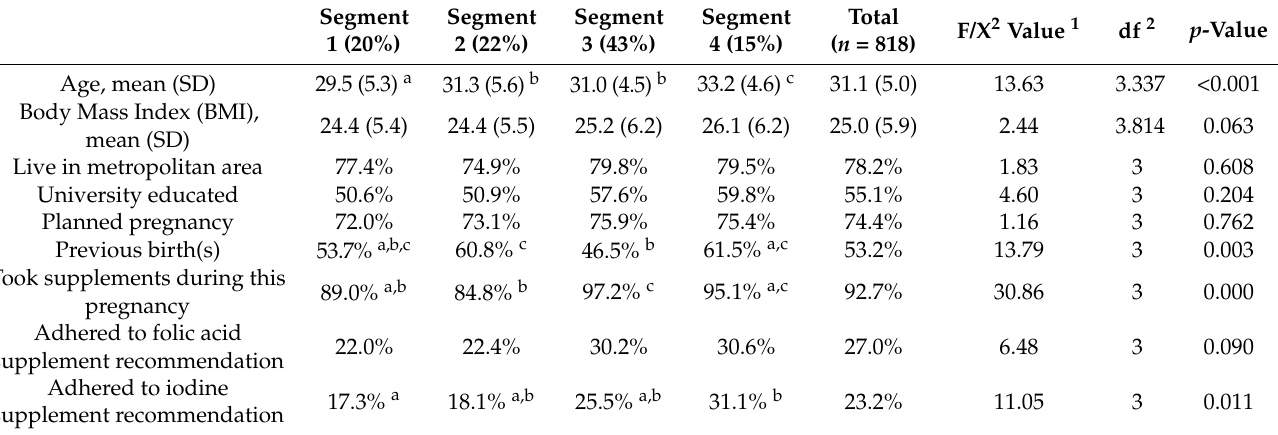
Table 5. Comparison of participant characteristics and behavior between segments ( n =